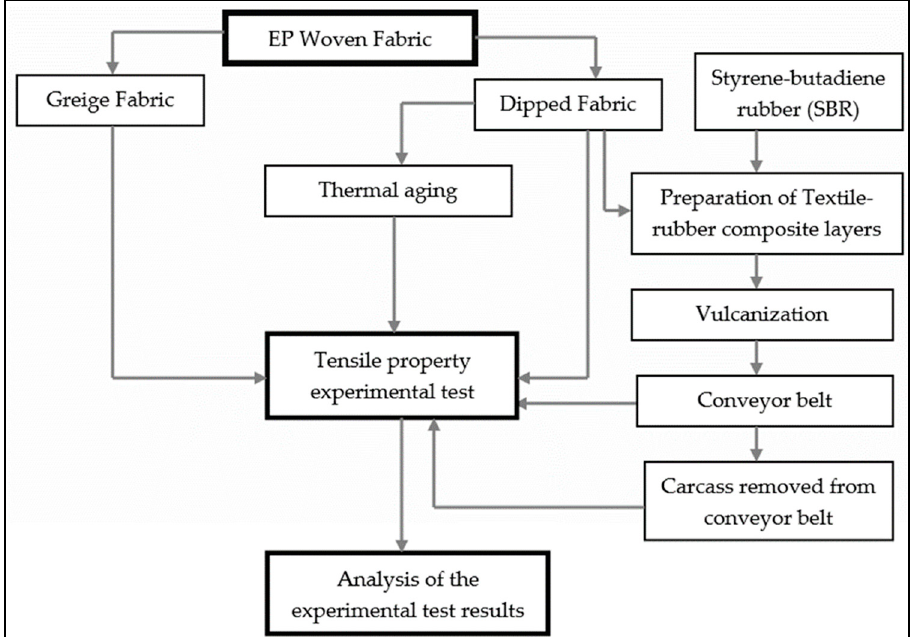
Figure 3. Experimental research flowchart.